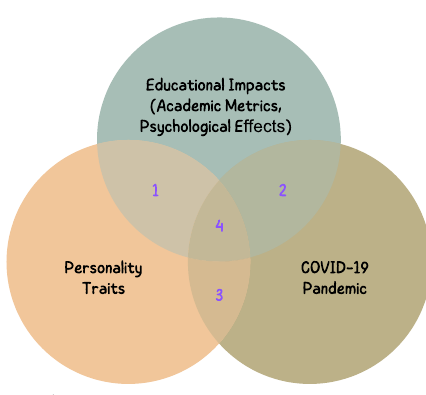
Fig. 1 Overlaps in related